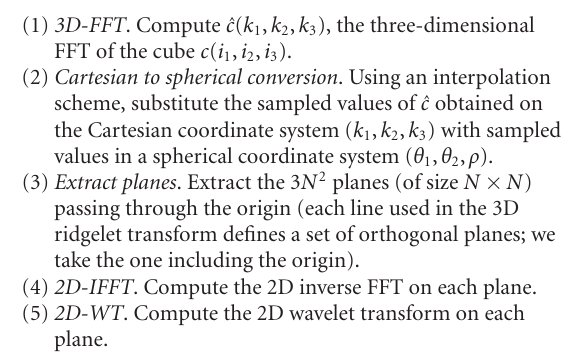
Algorithm 2: The 3D beamlet transform